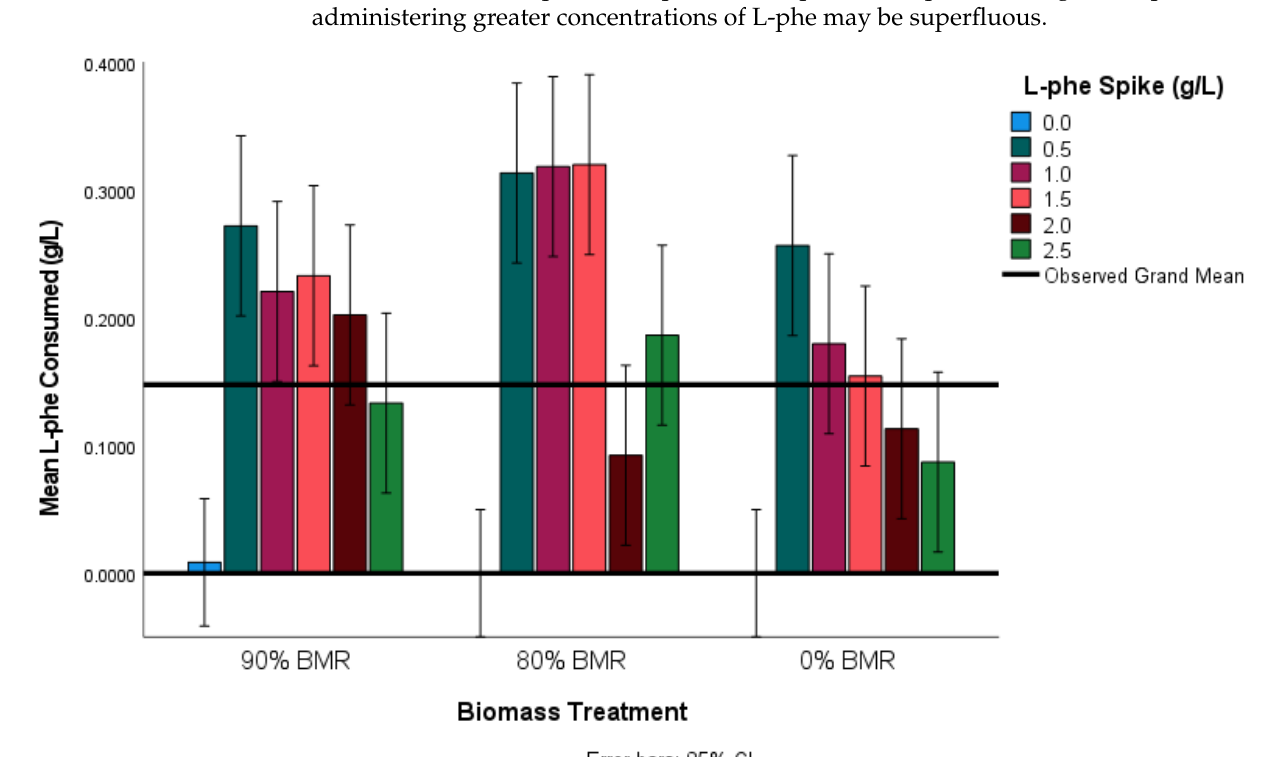
Figure 6. Bar graph indicating the average L-phe consumption of each treatment combination with error bars representing 95% confidence interval. The overall L-phe consumption for the 0% BMR treatment was significantly lower than the 80% BMR treatment. Additionally, the L-phe consumption of the 2.0/2.5 g L − 1 L-phe spike treatments collectively was lower than the 0.5 g L − 1 spikes across the combined biomass treatments. Table 2. Table showing the results of Scheffe’s test on L-phe consumed at different L-phe spike concentrations. Note that the 1.0 g L − 1 and 1.5 g L − 1 spikes are common to both subsets, while the 0.5 g L − 1 spikes are only seen in subset two, and the 2.0 g L − 1 and 2.5 g L − 1 spikes are only found in subset one. This indicates that the only statistical differences based on the L-phe spikes are found between the 2.0/2.5 g L − 1 spikes and the 0.5 g L − 1 spike. L-Phe Spike (g L − 1